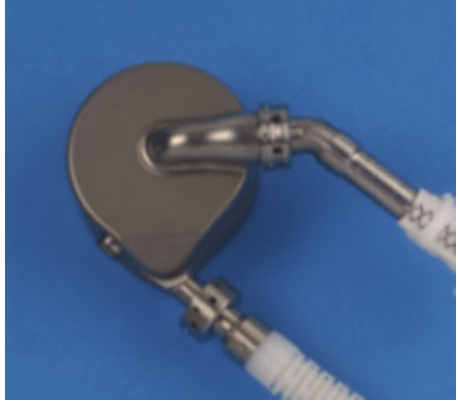
Figure 8 DuraHeart TM .